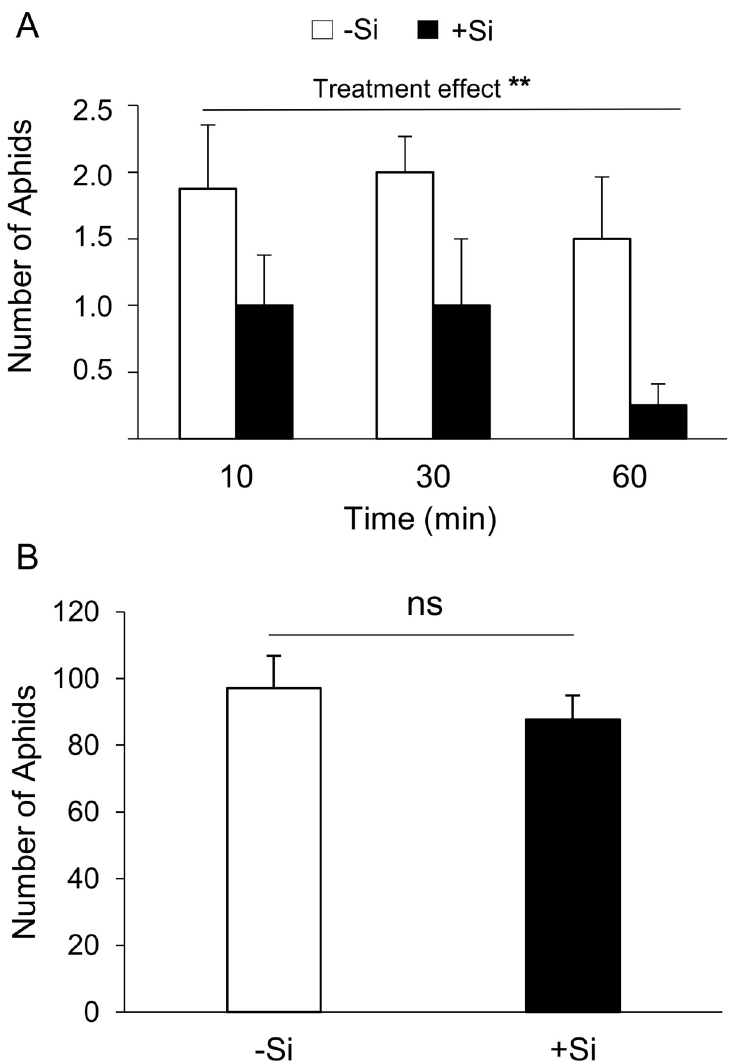
Fig 1. Effect of silicon supplementation on wheat direct defenses to the bird cherry-oat aphid. (A) Olfactory preference of Rhopalosiphum padi apterae (mean number of aphids ± SE) to Si-supplemented (+Si) and non-Si supplemented (-Si) wheat plants in arena choice assays along time course; (B) R . padi performance in +Si and -Si wheat plants based on the total number of aphids (mean number of aphids ± SE). ns = not significant; �� indicates significant difference between treatments at 1% according to